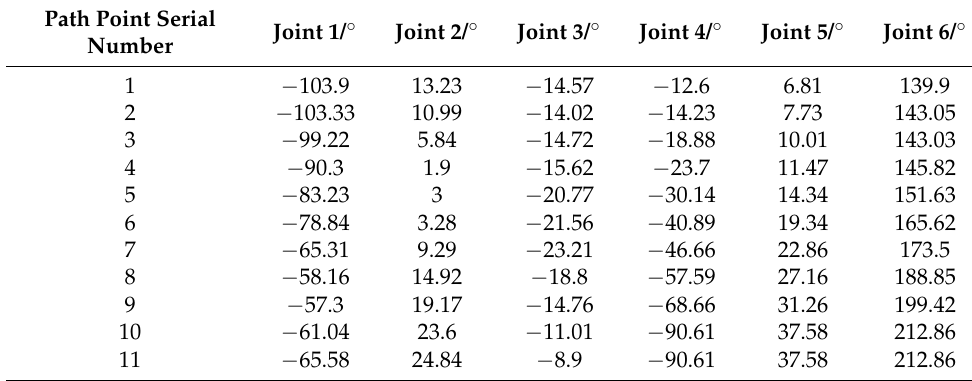
Table 6. Joint path of the manipulator.